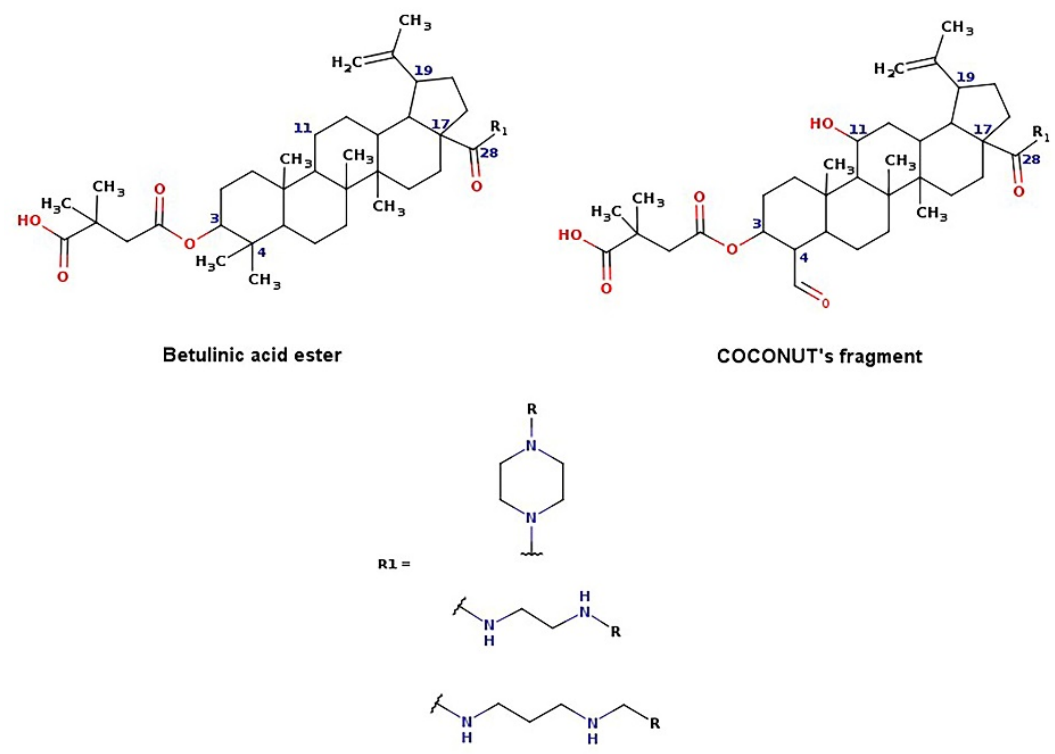
Figure 5. Template for building new chemical compounds similar to bevirimat using the ester of betulinic acid to ChemDiv fragments and Enamine fragments, and the ester of COCONUT’s fragment derived from 24-nor-3 α ,11 α -dihydroxy-lup-20(29)-en-23,28-dioic acid.